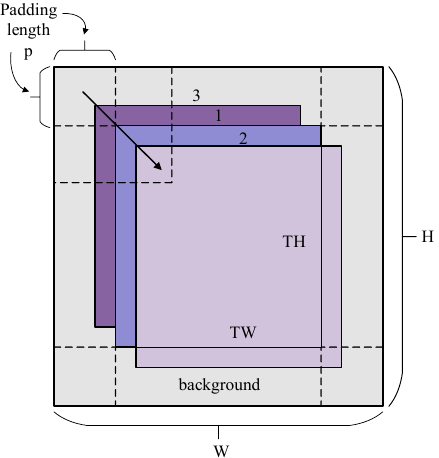
Figure 3. Circular samples based on the local region. The base sample is the target at the center of the image patch shown as the bounding box 1. Box 2 and 3 respectively indicate the circular shifts of the base sample. The arrow in the figure represents the direction of the circular shift.